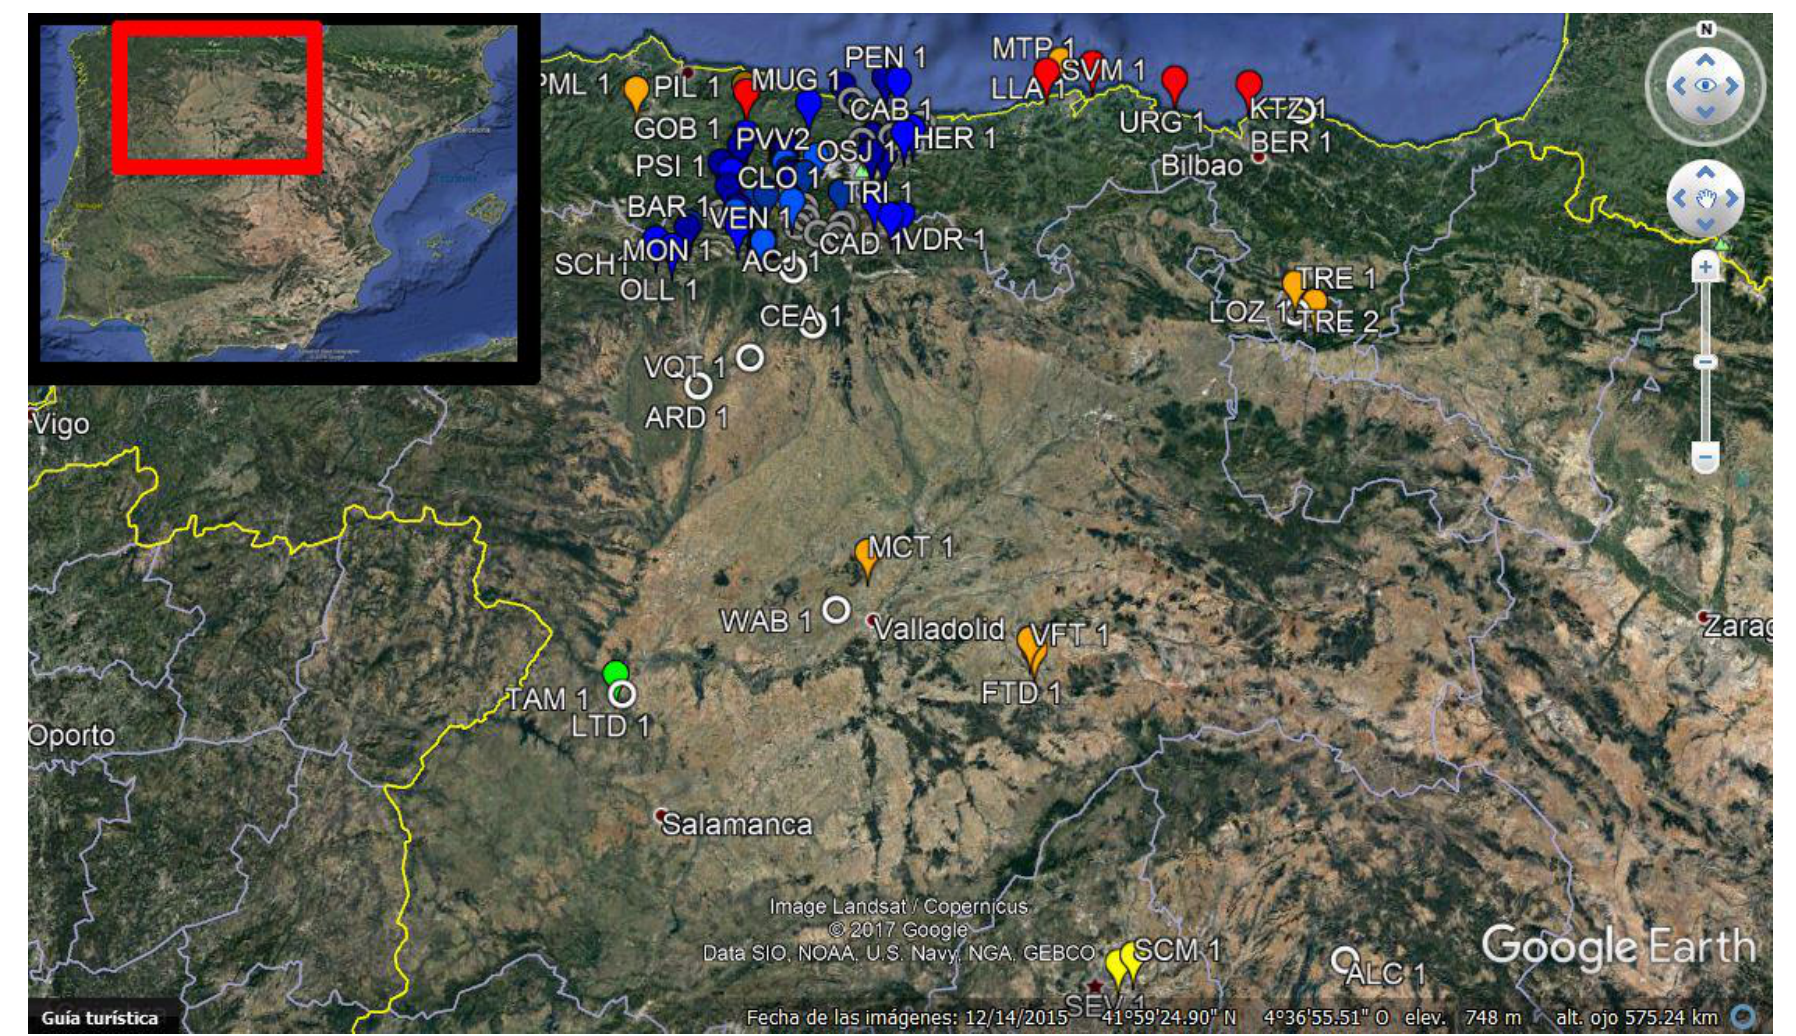
Figure 6: Map with the different outcrops included in the LegioLit at the University of León (Source: Google